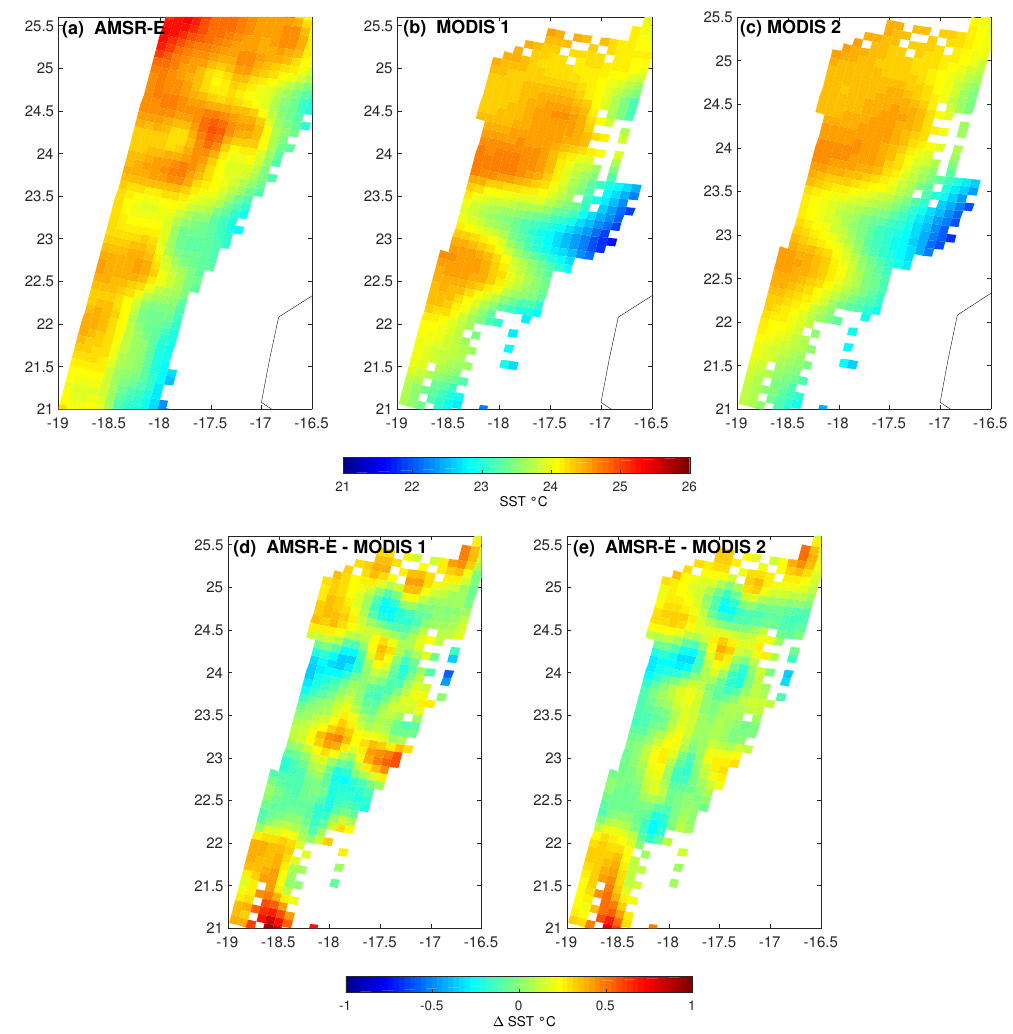
Figure 15. Comparison of ( a ) the AMSR-E SST field of 0155 UCT, 2009-10-31 with the coincident MODIS SST field assuming ( b ) a 56 × 56 km 2 footprint, and ( c ) assuming the footprint represented by Figure 10. The AMSR-E SST field minus the two MODIS derived fields are, respectively, shown in ( d , e